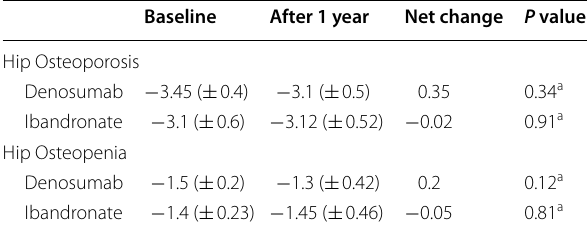
The Student T-test was used for normally distributed variables; significance was found at P 0.05 ≤ a Nonsignificant difference between the two groups